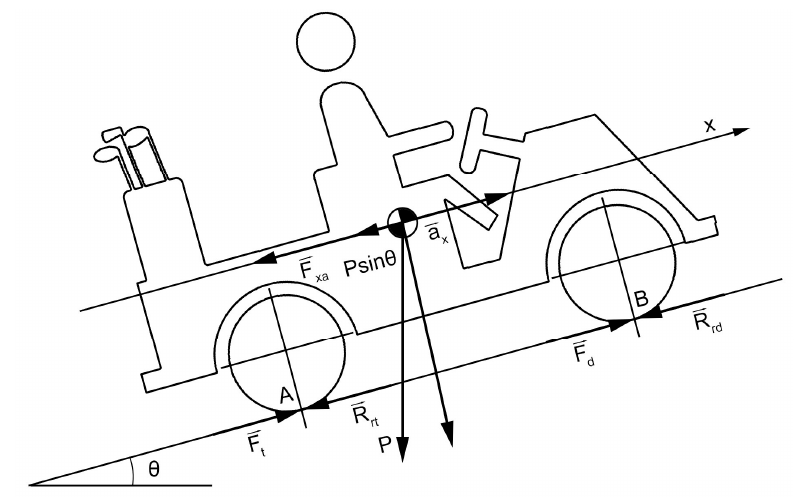
Figure 5. Physical factors to model and design the traction Figure 5 . Physical factors to model and design the traction system.